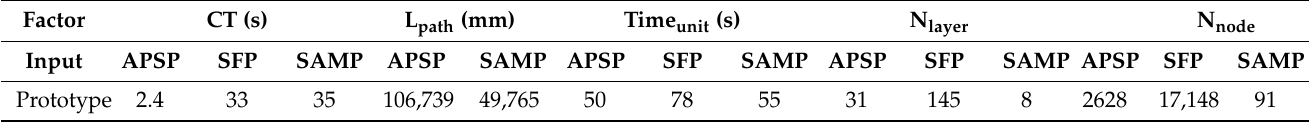
Table 1. Data for a printing simulation: computational time (CT), path length (L path ), unit